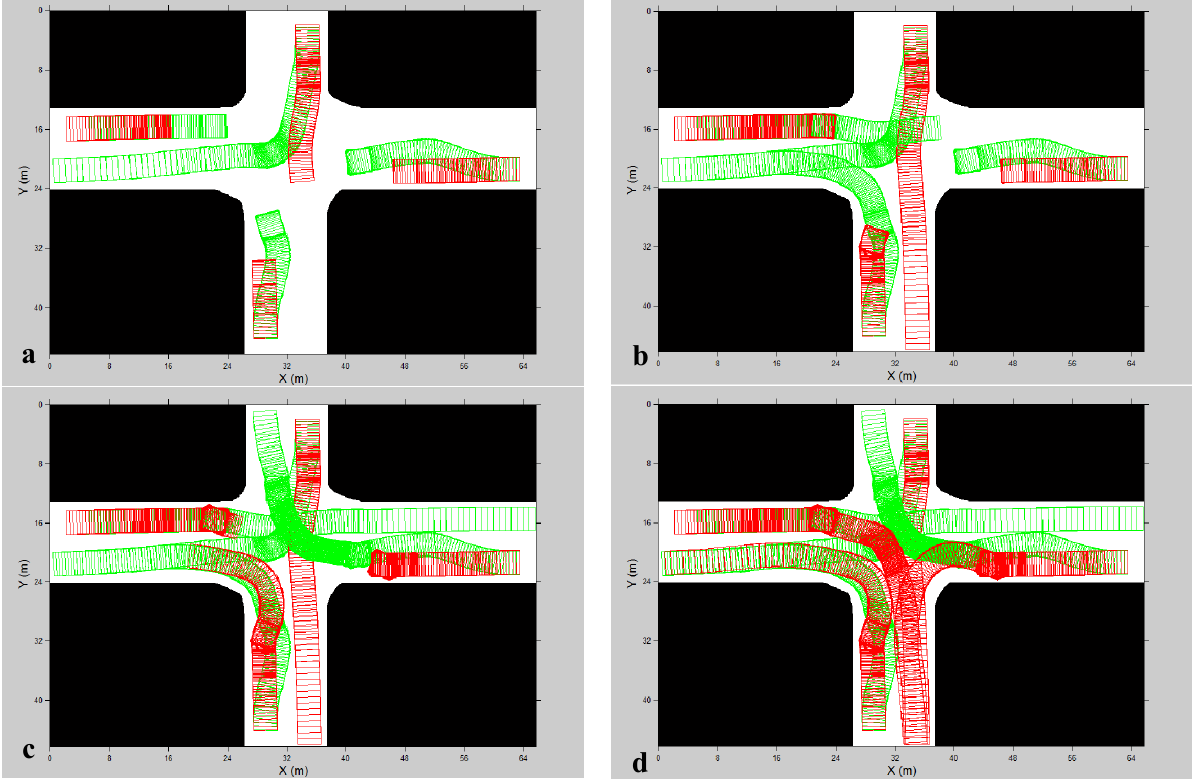
Figure 13. Simulation results in crossing scenario. ( a ) t = 6 s; ( b ) t = 10 s; ( c ) t = 21 s; ( d ) t = 29